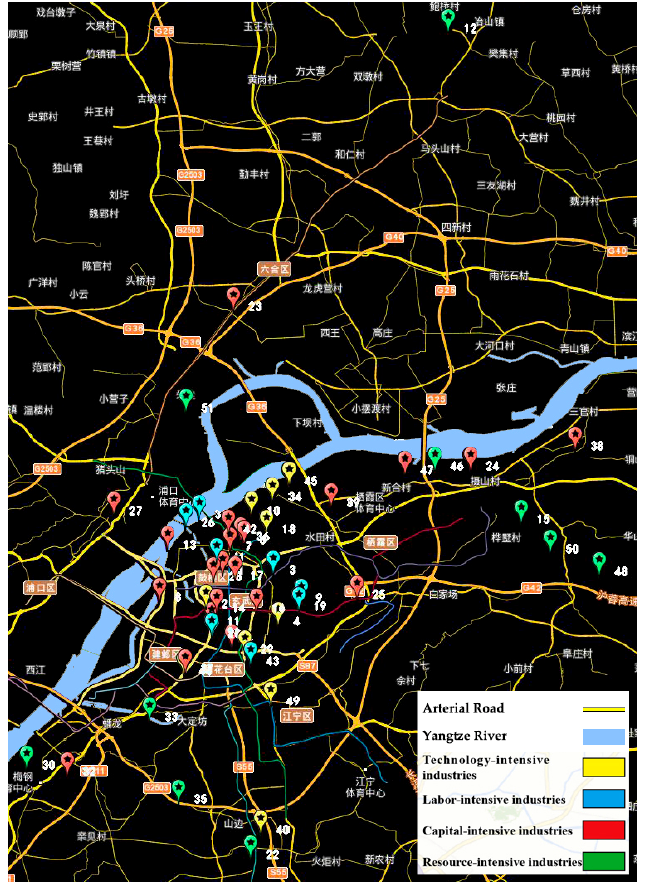
Figure 6. The relationship between the four industrial types of Nanjing Industrial Heritage Sites, arterial roads and Yangtze River shoreline (Figure source: own drawing; data from: